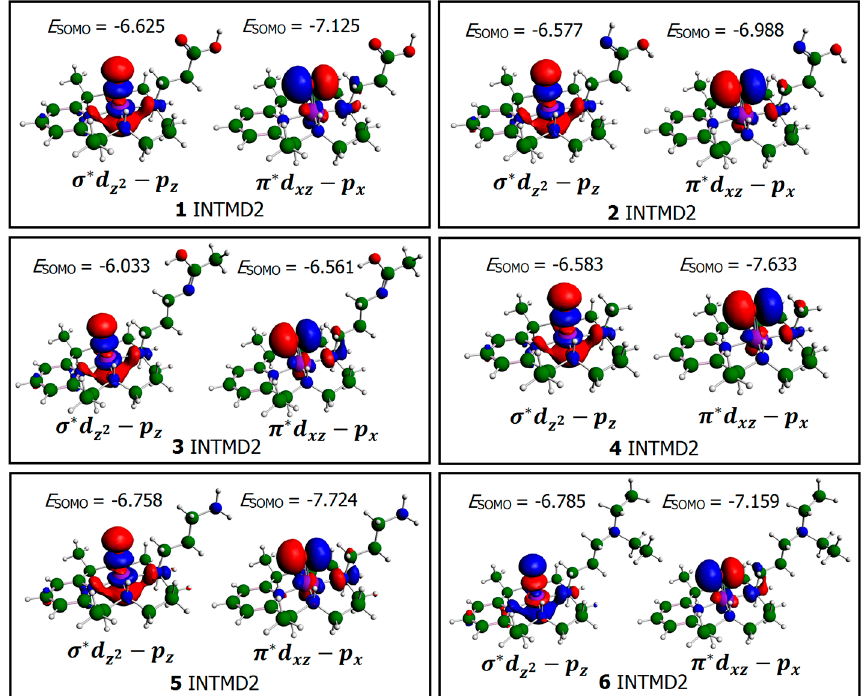
Figure 5. Singly occupied molecular orbitals (SOMO) of the active high-spin ( S = 1) [(L)Ni 3 + –O · ] 2 + intermediates calculated with solvation effects. E SOMO values are the corresponding orbital energies in eV. Molecular orbitals are named based on the computed spin density distributions in Ni and O axial (see Table 5) and their interaction. The x, y, and z axes point along N(1)–N(3), N(4)–N(2), and Ni–O axial directions, respectively (numbering of nitrogen atoms is similar to that in Figure 3).